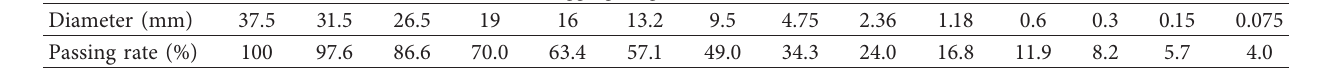
Table 1: Aggregate gradation for LSAM-30.